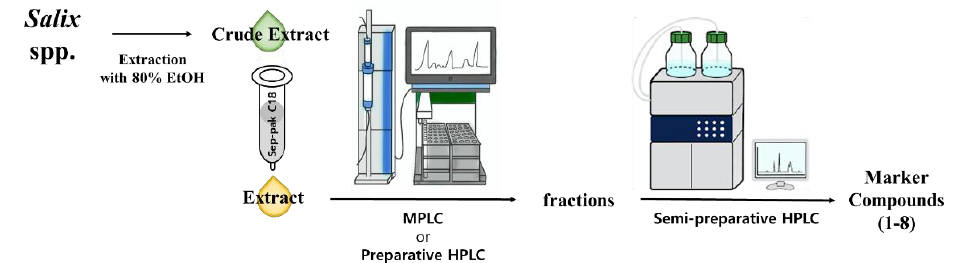
Figure 2. Separation scheme of the marker compounds 1 – 8 .